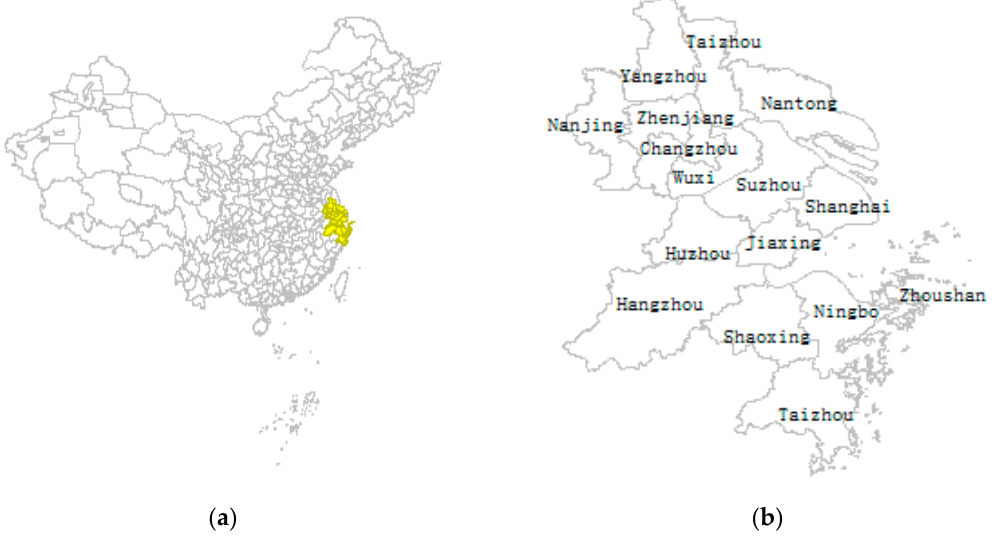
Figure 1. Location and area map of the Yangtze River Delta. ( a ) Location map of the Yangtze River Delta and ( b ) Map of the Yangtze River Delta.